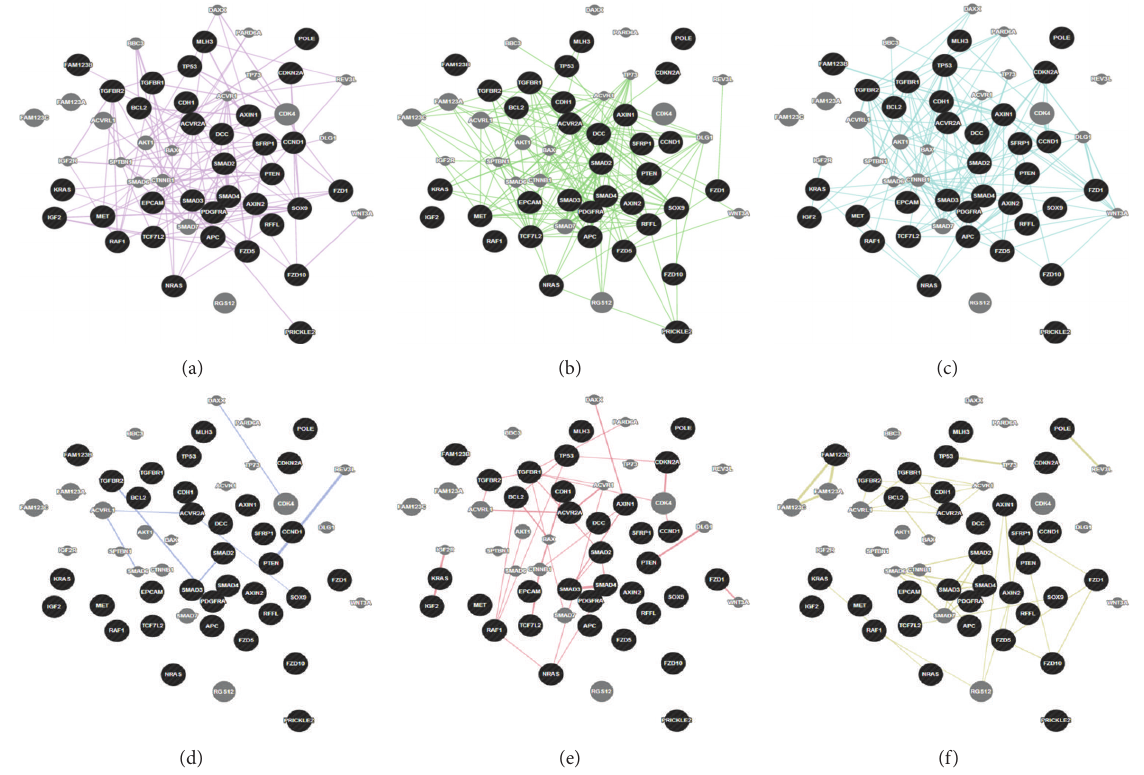
Figure 5: This figure is a representation of all the individual networks retrieved from GeneMania. From the top left to the bottom right, they display coexpression, genetic interactions, and pathways, coexpression, protein-protein interactions, and shared protein